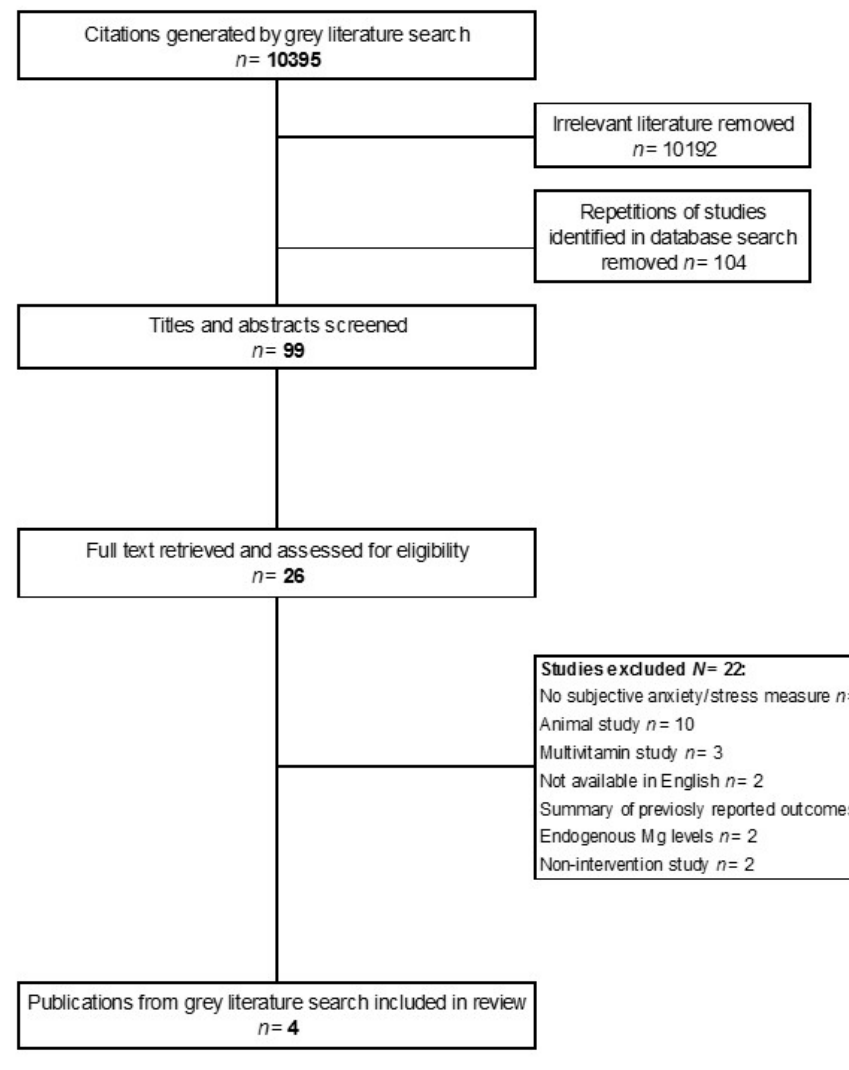
Figure 2. Grey literature search study selection summary.